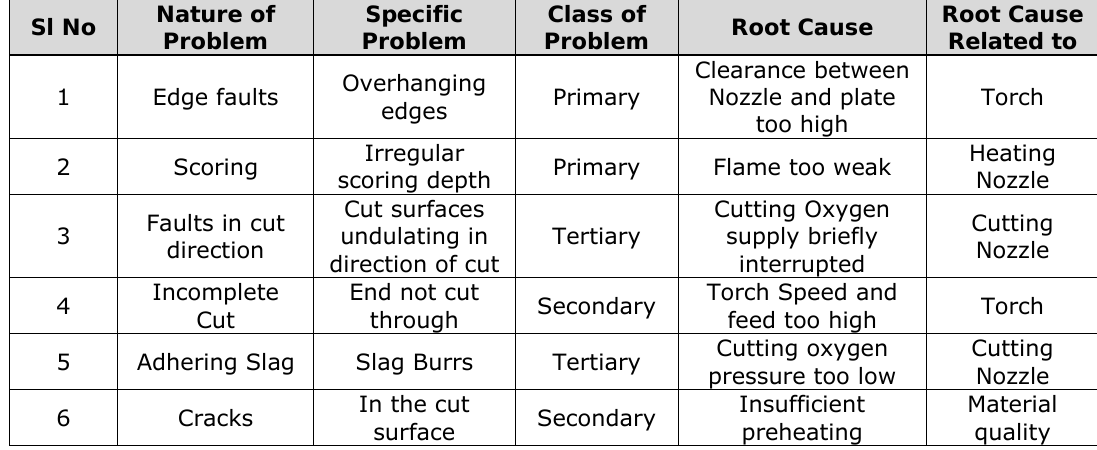
Table 5. “Types of errors and their root causes in processed